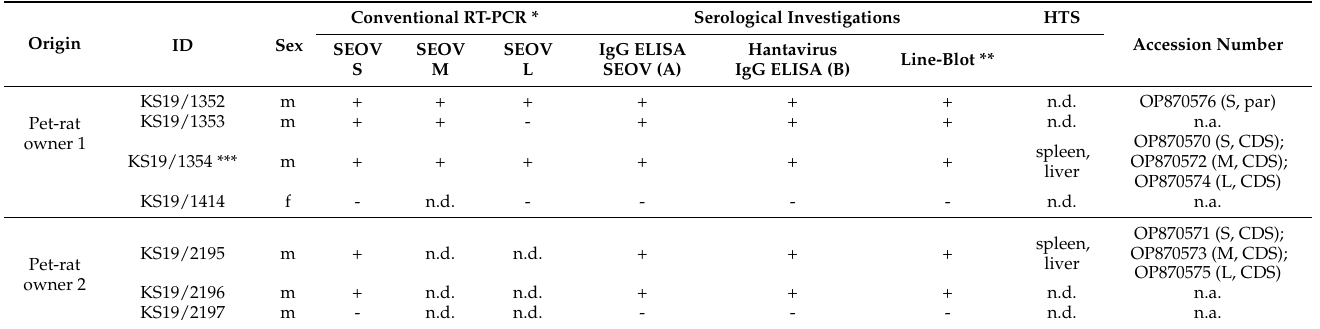
Table 1. Molecular and serological analysis of rats from patient/pet-rat owner 1 and from pet-rat owner